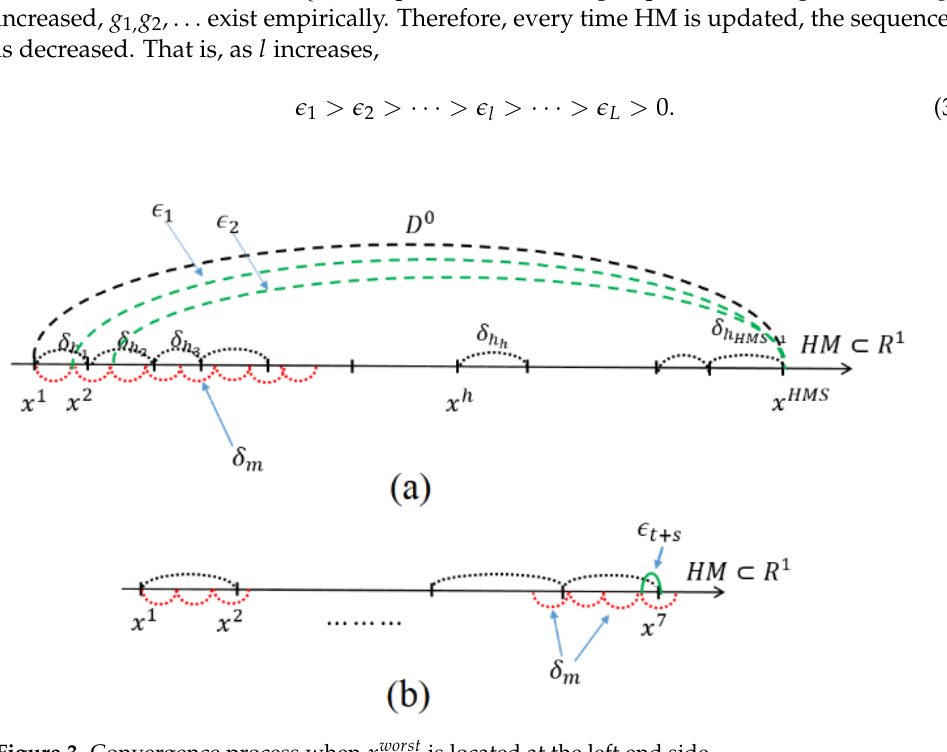
Figure 3. Convergence process when 𝑥 𝑤𝑜𝑟𝑠𝑡 is located at the left end side